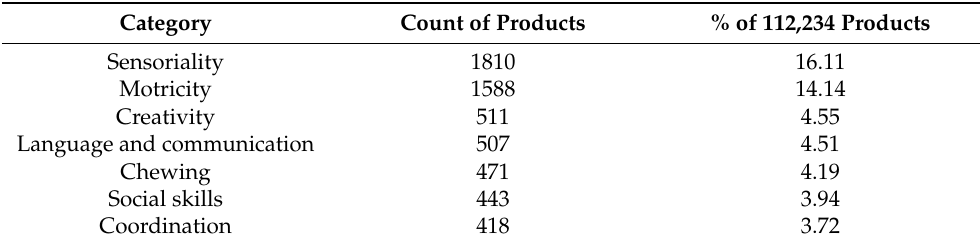
Table 14. Categories of Toys based on ASD needs with more